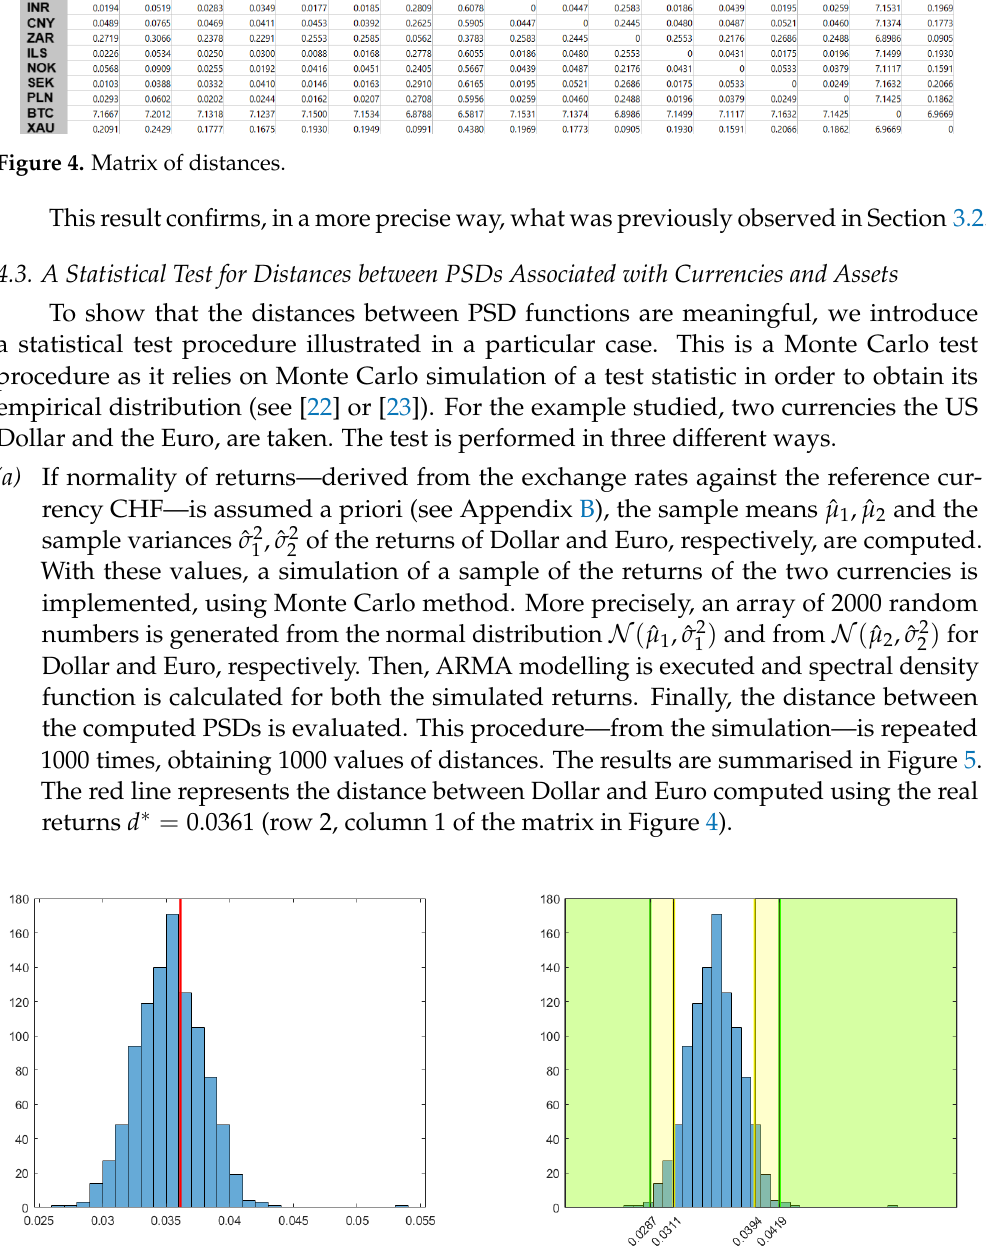
Figure 5. Case (a): probability distribution of the distance between Dollar and Euro ( left ) and rejection areas for α = 0.995 (green) and α = 0.95 (yellow) ( right